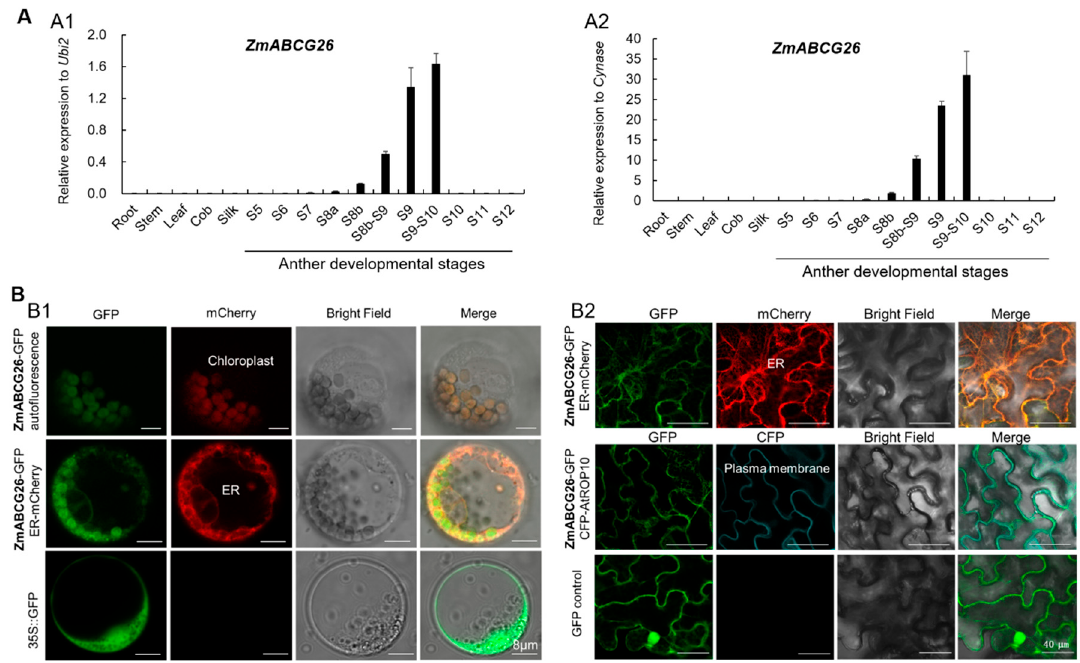
Figure 3. Spatiotemporal expression analysis of ZmABCG26 gene and subcellular localization of ZmABCG26 protein: ( A ) spatiotemporal expression analysis of ZmABCG26 by qRT-PCR assay with ZmUbi2 ( A1 ) and ZmCynase ( A2 ) as the internal control, respectively. Error bars indicate SD. Each reaction was performed in three biological replicates with three technical repeats; ( B ) confocal images showing the subcellular localization of ZmABCG26 in maize protoplasts and tobacco leaf cells. The constructs of ZmABCG26-GFP , 35S-GFP , ER-mCherry ( mCherry-HDEL ), and CFP-AtROP10 were expressed in maize protoplasts ( B1 ) or tobacco leaf cells ( B2 ). The chlorophyll autofluorescence was used as a plastid marker. The ZmABCG26-GFP was cotransformed with the ER-mCherry as an ER marker in maize protoplasts and tobacco leaf cells, and also cotransformed with the CFP-AtROP10 as a plasma membrane marker in tobacco leaf cells. The 35S-GFP vector was used as a negative control. Scale bars, 8 µ m ( B1 ) and 40 µ m ( B2